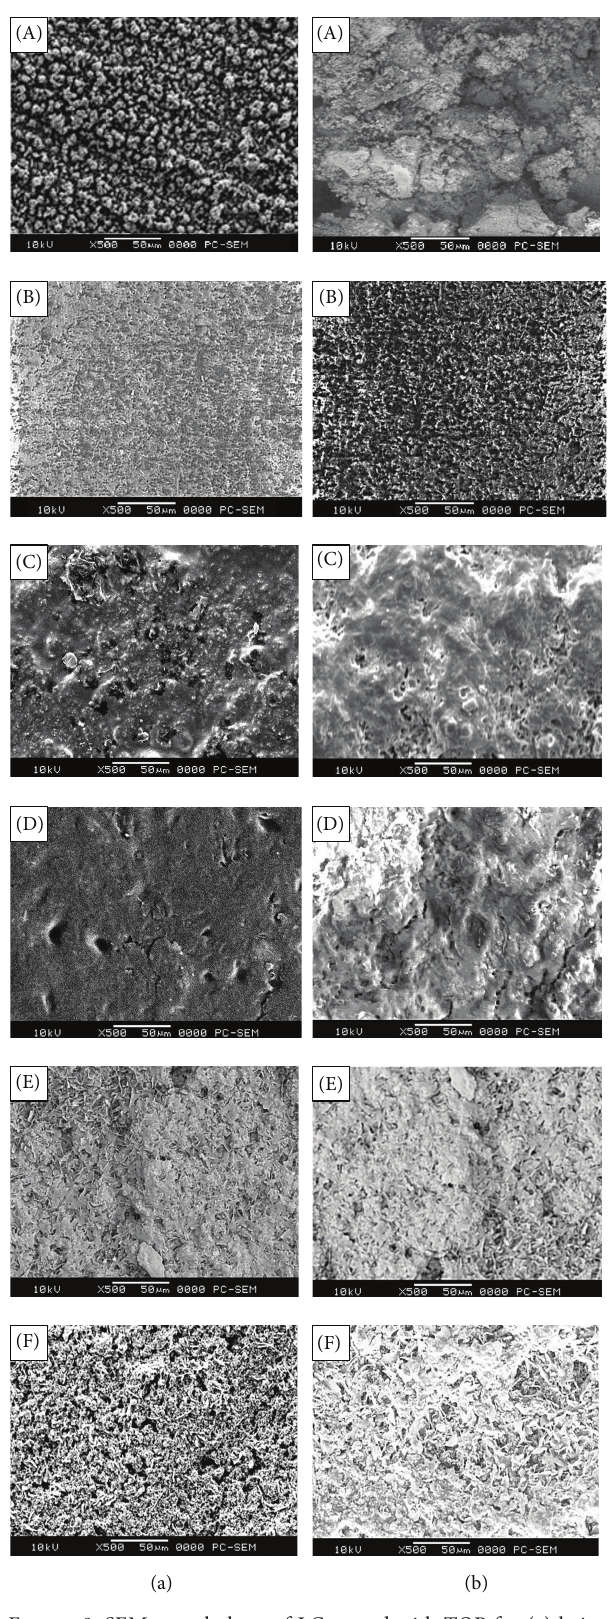
Figure 8: SEM morphology of LC coated with TOP for (a) being exposed and (b) after being exposed to sunlight and night humidity for samples (A), (B), (C), (D), (E), and (F).